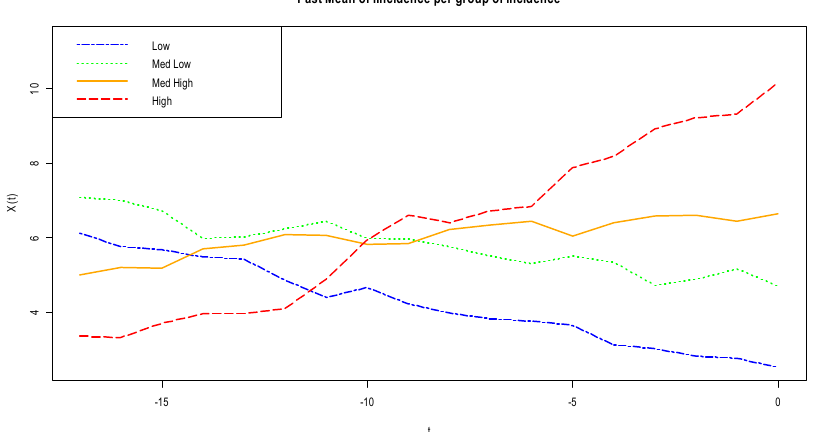
Figure 2. Mean curves of past functional meteorological covariates per group of malaria incidence b . Clockwise from top left: fTemperature, fHumidity, fWindspeed, and fRain mean curves groups. The groups are constructed based on values of the quantile of the incidence values: low [0, 2.5] (dark blue line), medium low (2.5, 5] (green line), medium high (5, 10] (black line), and high (10, 20] (dark red line). Altogether, if we observe a mean humidity pattern (>65%), mean rain events (>2), and mean wind speed (<1.8 m.s − 1 ) about 10–12 weeks before, then we will probably suffer a peak in malaria incidence in Dangassa.